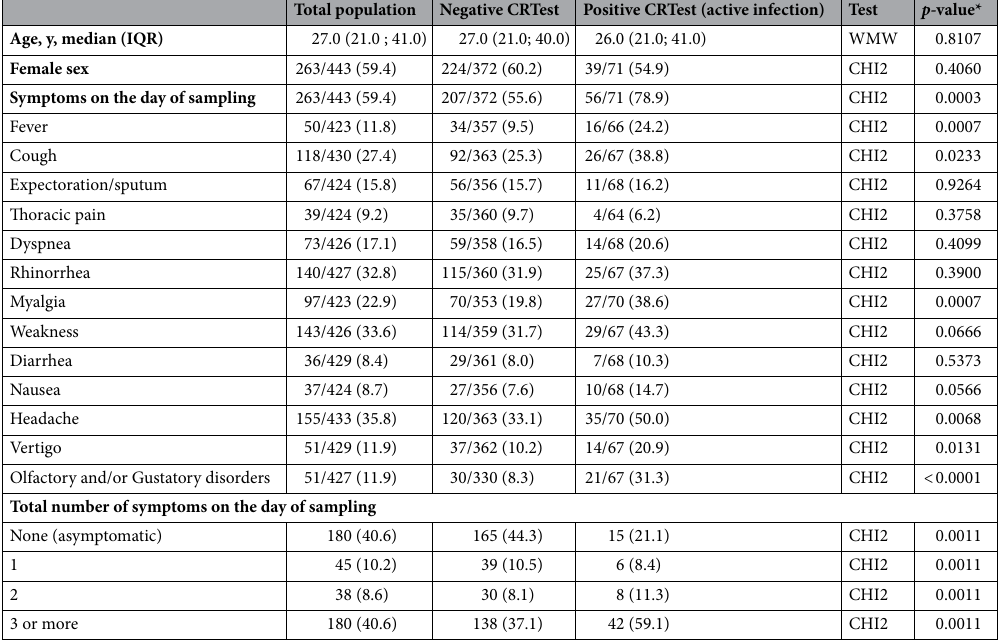
Table 1. Demographic and clinical characteristics. Unless otherwise indicated, data are reported as n/N (%). Denominators vary because of missing data for some participants. CRTest composite reference test, IQR interquatile range. * p -values for comparisons between patients with positive and negative PCR.